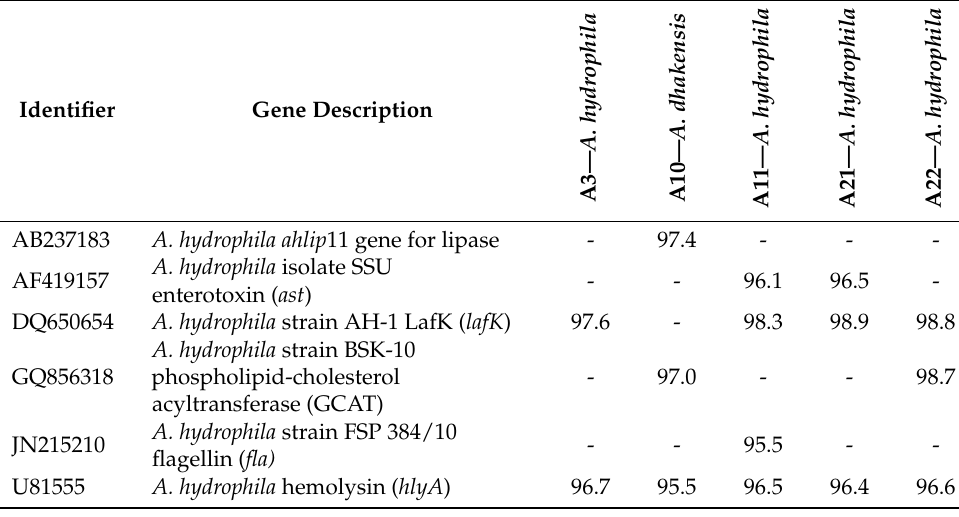
Table 5. Percent alignment of genes identified in Aeromonas hydrophila isolates from a central Texas dairy farm to Aeromonas -specific virulence genes selected from